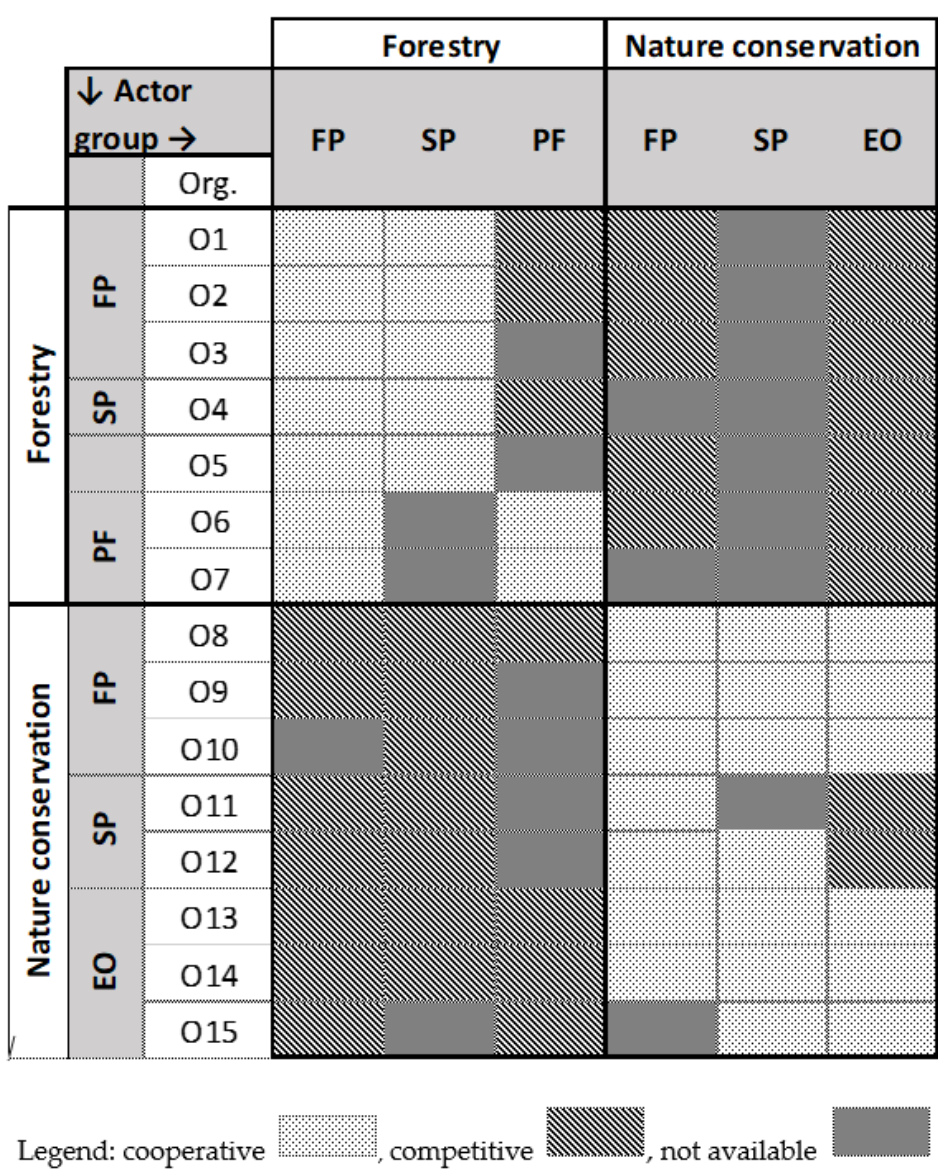
Figure 1. A socio-matrix of cooperative and competitive orientations of forestry and nature conservation actors with respect to the use of technical forest information for forest policy making at federal